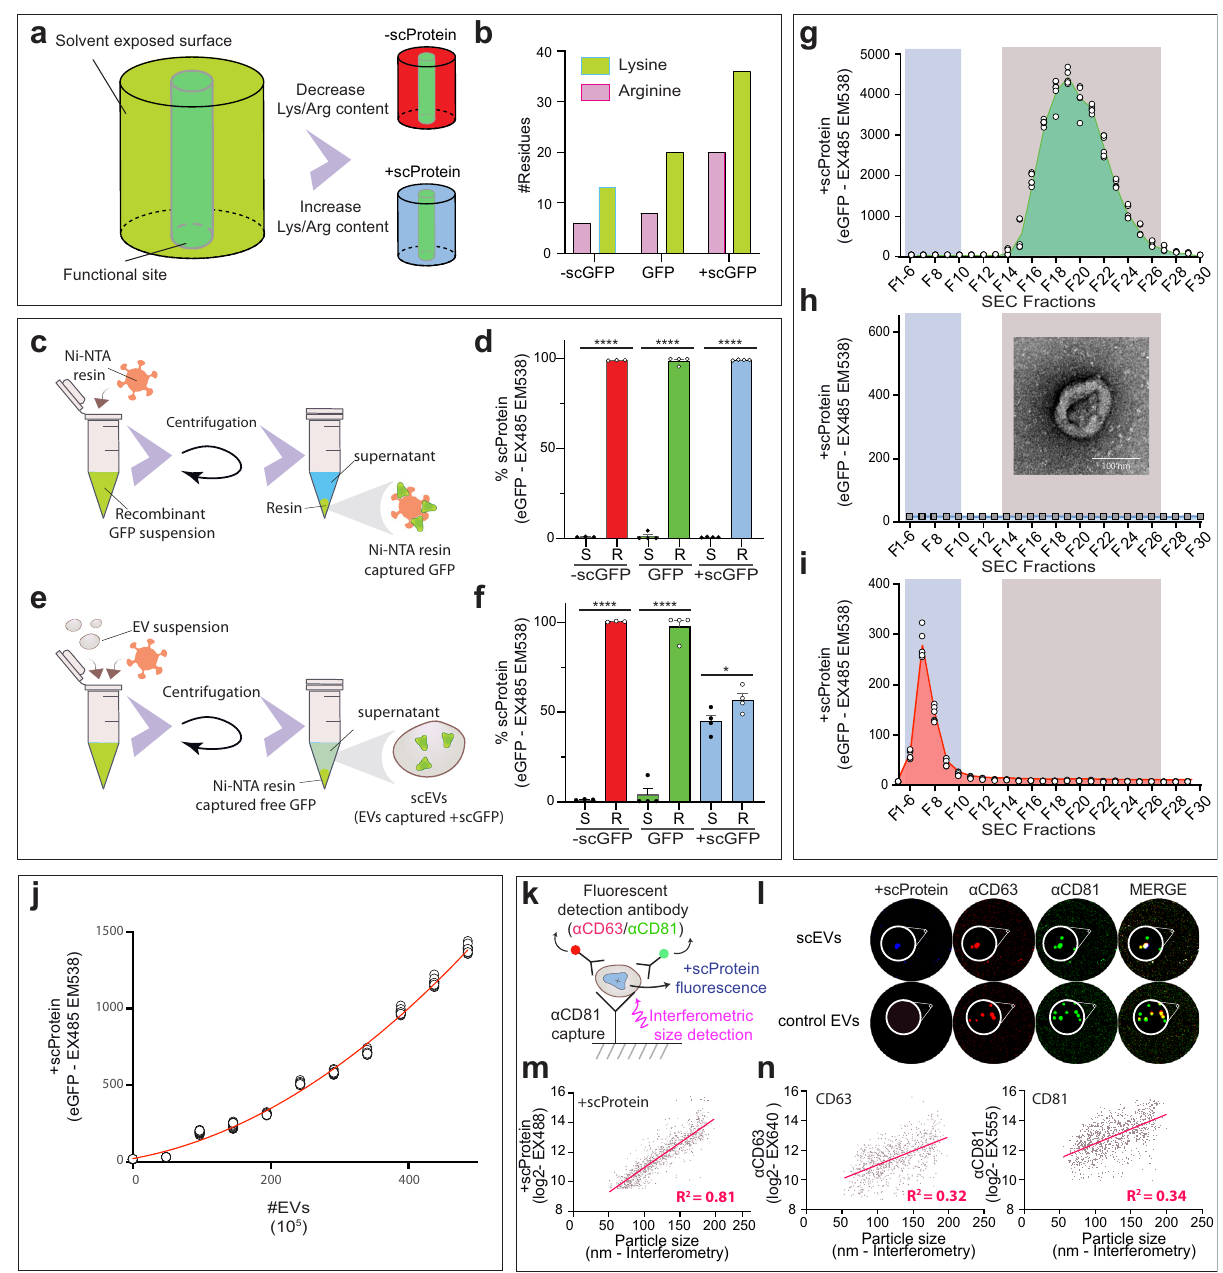
correlation is log 2 (Y) = 0.03 * X + 7.7 (R2 = 0.81; p < 0.0001), the size of EVs. The slope of this correlation (slope = 0.03) was (slope = 0.019) detection antibody emitted fl uorescence with IM tionship between the fl uorescence and the IM was lower for CD81 (R2 = 0.34) and CD63 (R2 = 0.32). Altogether, our data indicates EVs by the donor HEK293T cell and that exogenous + scProtein loading is more size dependent compared to endogenous loading the EV size indicated by IM (Fig. S3c-I) and anti-CD63 probe fl uorescence (Fig. S3c-II) of CD63 + CD81 + events between non- CD63 + CD81 + subpopulation the size of single EVs was larger COMMUNICATIONS BIOLOGY| (2022) 5:485